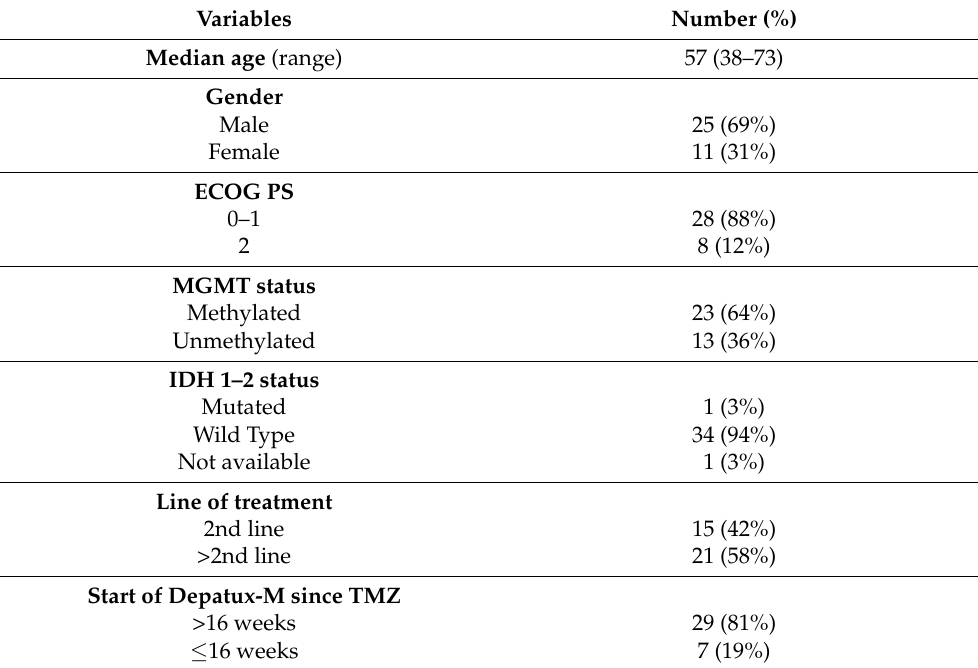
Table 1. Baseline patients and tumor